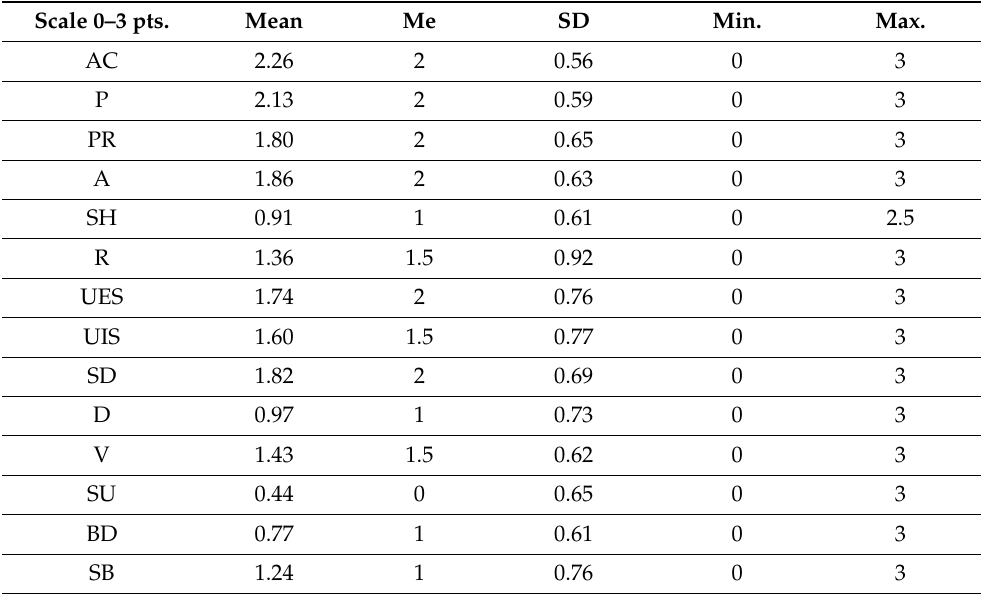
Table 3. Strategies for coping with difficult situations (Mini-COPE). Scale 0–3 pts. Mean